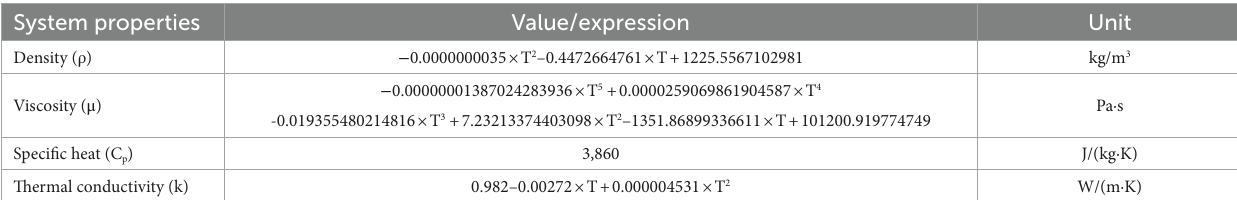
TABLE 2 Relevant